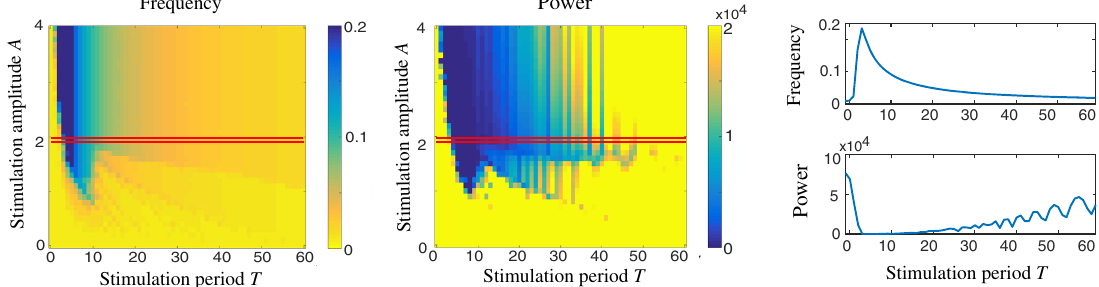
FIG. 5. Desynchronization induced by high-frequency periodic stimulation of the Fitzhugh-Nagumo network equation (with same parameters used in Fig. 1 and with J ¼ 1 . 5 and σ ¼ 1 . 5 ) for various values of the amplitude A and period T of the stimulation current. (a) Trajectories and desynchronization. Dynamics of the average voltage (blue) and recovery variable (red). The system becomes desynchronized for relatively high-frequency stimulation ( T ¼ 5 ), once the amplitude of the stimulation becomes strong enough to perturb the system. Increasing further the stimulation frequency leads to the return of intrinsic oscillations ( T ¼ 1 ), while slow periodic forcing induces a phase locking with the stimulation ( T ¼ 40 ). (b) Top: The maximal value of the average voltage clearly delineates a region of desynchronization (in blue), corresponding to a dip in the maximal average as visible for fixed amplitude (bottom graph, corresponding to the red slice in the upper diagram). (c) Preferred frequency and maximal power of the Fourier transform of the average recovery variable delimitates regions of synchronization (yellow), desynchronization (dark blue), and period skipping, with sections at fixed amplitude (red slices in the heat maps and right-hand